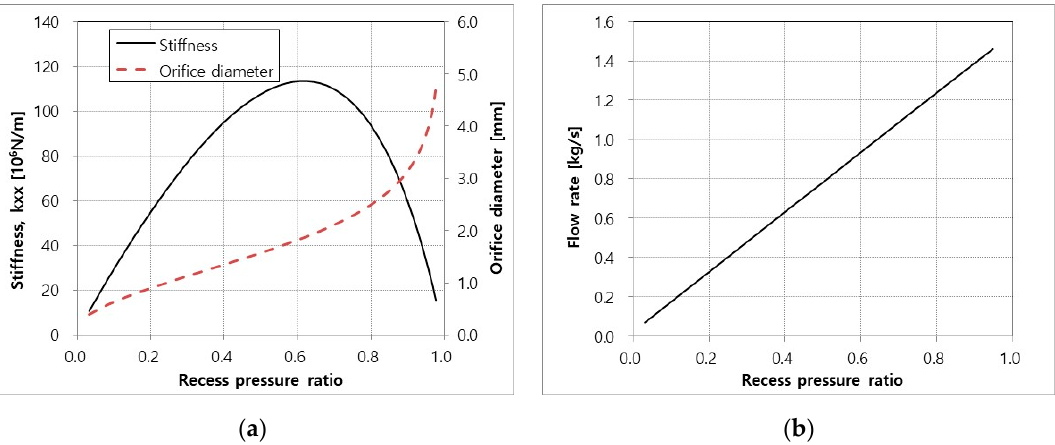
Figure 5. Stiffness and flow rate for recess pressure ratio ( p s = 70 bar, p e = 60 bar, ω = 21,000 rpm). ( a ) Stiffness; ( b ) Flow rate.